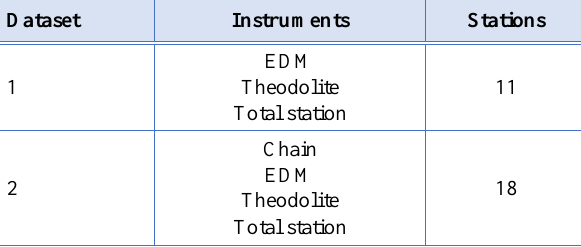
Table 1. Combination of the instruments used for datasets in cadastral